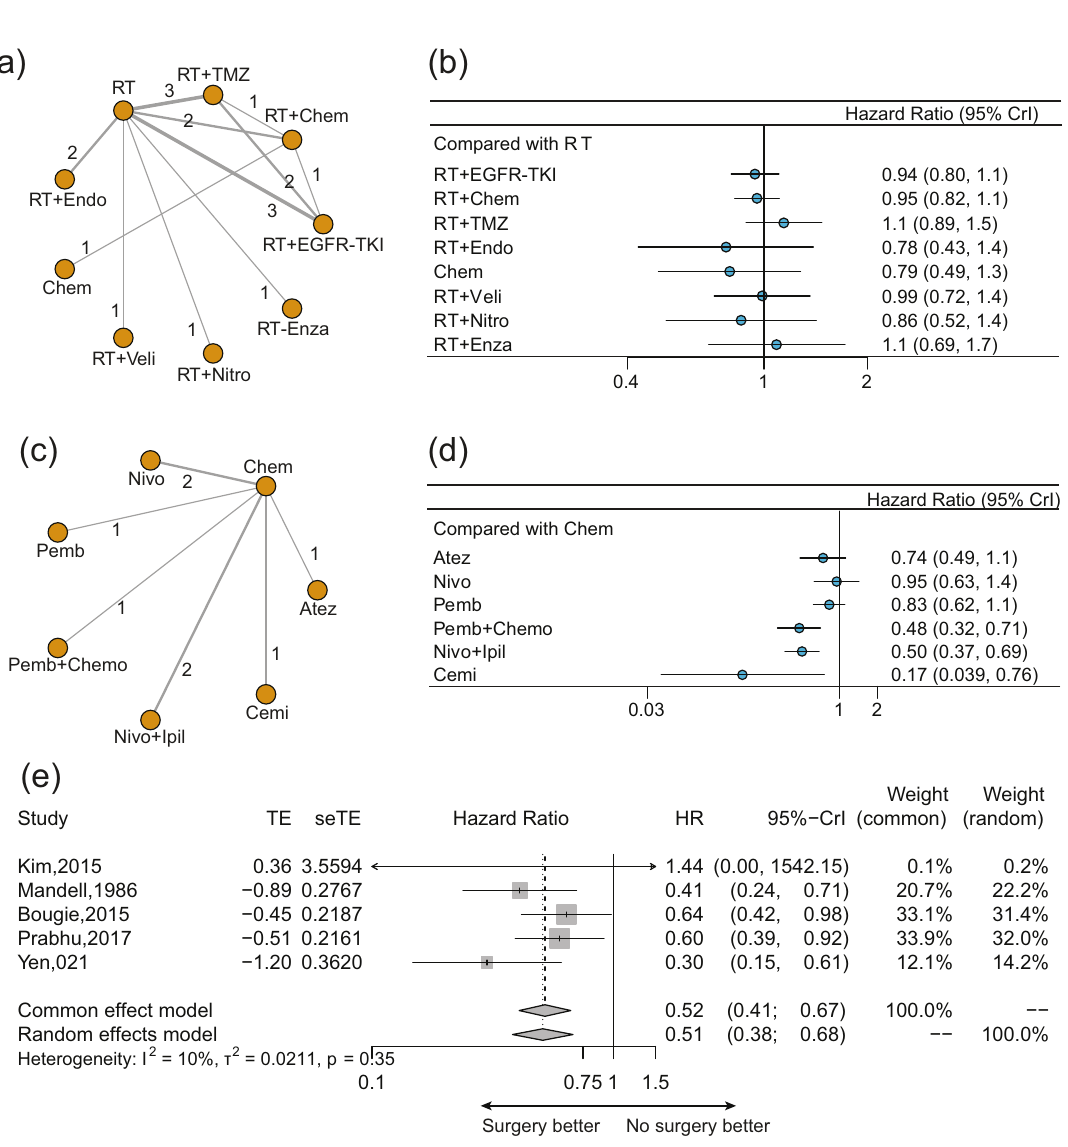
derived HR for treatments compared with each other are demonstrated in Figure S2. Five trials compared OS for patients who performed surgery or not ( Figure 2e ) . Surgical resection of BMs from NSCLC was associated with a signi fi cantly favorable OS than radiotherapy alone ( HR: 0.52, 95% CrI: 0.41 – 0.67, common e ff ect model ) .